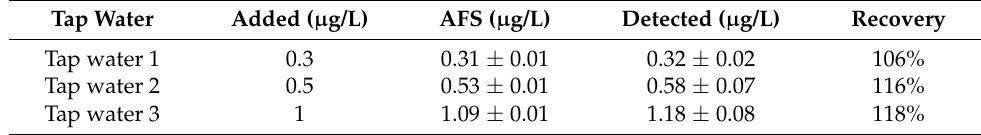
Table 1. Analytical result by the TC-IL-DLLME-DPSV method in tap